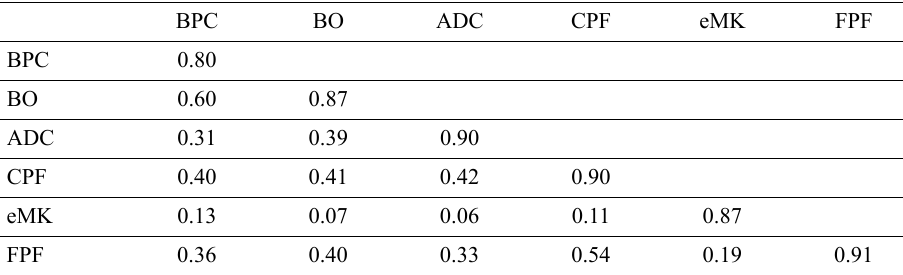
Table 3. Discriminant validity of research